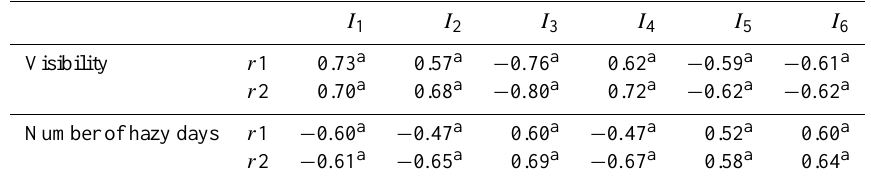
Table 3. Correlation coefficients of visibility and number of hazy days and circulation